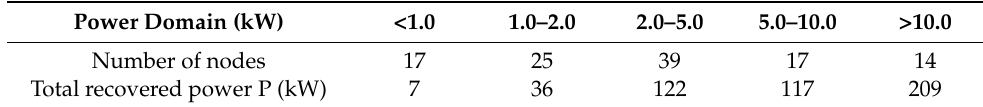
Table 8. Node’s number and recovered energy in the heating season.